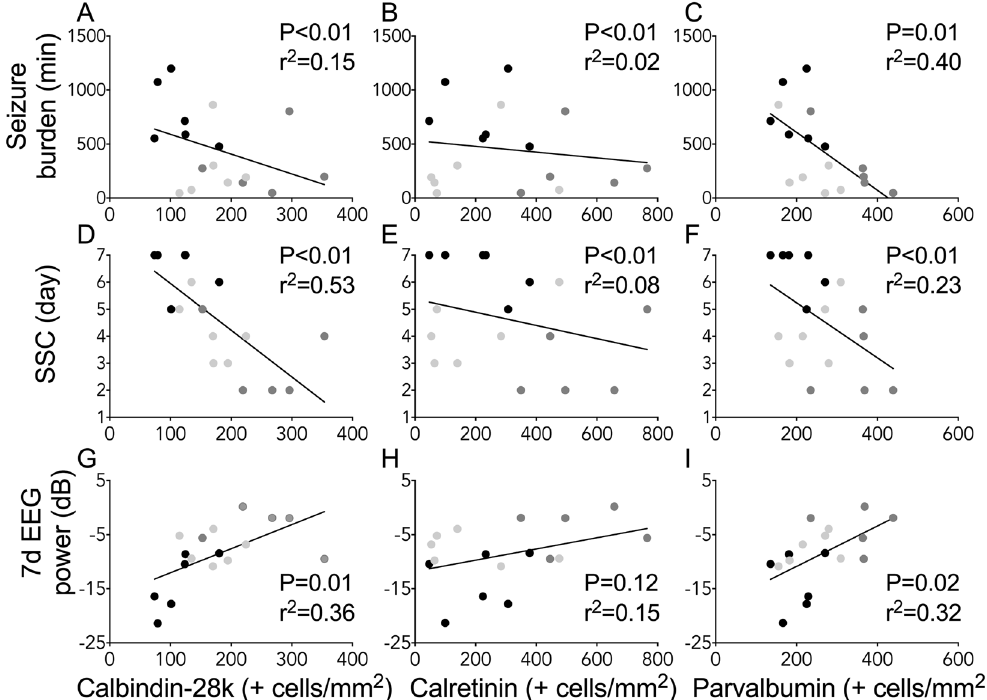
Figure 5. Correlations between neurophysiological outcomes and histopathology in ischaemia + vehicle, n = 6; ischaemia + short infusion, n = 6 and ischaemia + long infusion, n = 5 (neurophysiological data were not available from 1 subject in the ischaemia + long infusion group). Panels ( A–C ) Correlations between